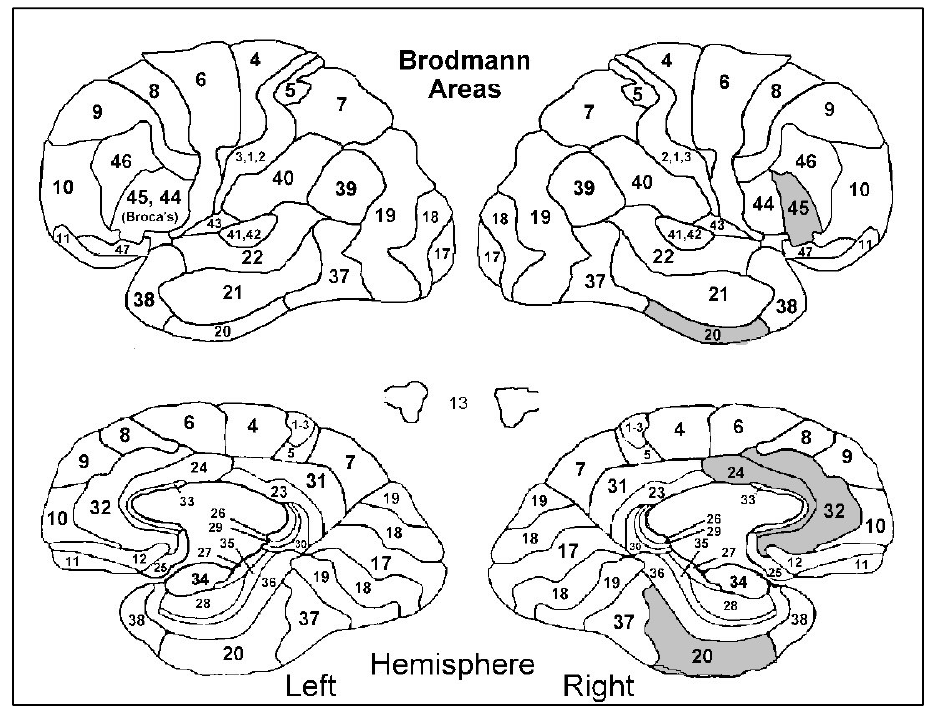
Figure 1. Hypoperfusion in Brodmann areas 20R, 24R, 32R, 45R (right inferior temporal cortex, right ventral and dorsal anterior cingulate cortex, and right inferior frontal gyrus—triangular part) was associated with a higher anosognosia total score.